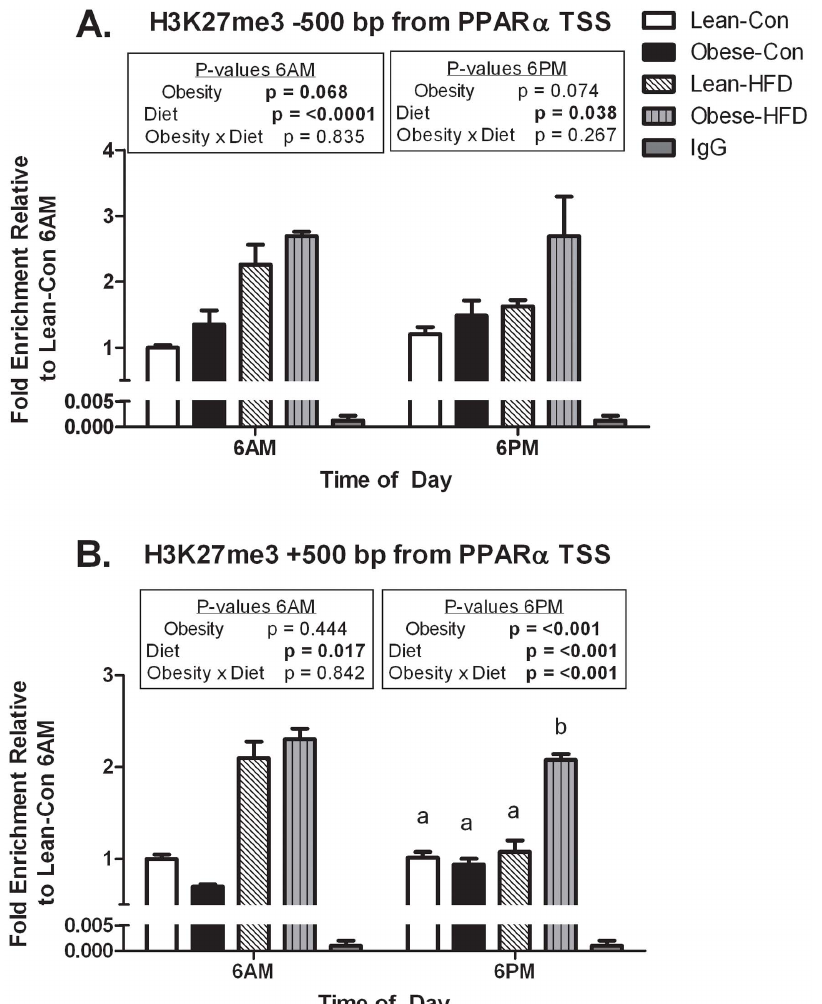
Figure 5. H3K27me3 enrichment on the PPAR a promoter. Chromatin immunoprecipitation for H3K27me3 was carried out and A) upstream ( 2 500 base pairs) and B) downstream ( + 500 base pairs from TSS) regions of the PPAR- a gene were amplified in pools of liver samples (each pool represents 3–5 separate animals) from offspring of lean or obese dams fed either control or HFD (run in triplicate). Enrichment was determined by real time RT-PCR and normalized to input levels. Data are presented as mean 6 SEM. Statistical differences were determined using a two-way ANOVA to examine the effects of maternal obesity and post-weaning HFD (P , 0.05). Significant interactions were followed by one way ANOVA and Student- Newman-Keuls post hoc analyses (P , 0.05). Bold values represent significant main effects and interactions and values with different letter superscripts are significantly different from each other (P , 0.05).